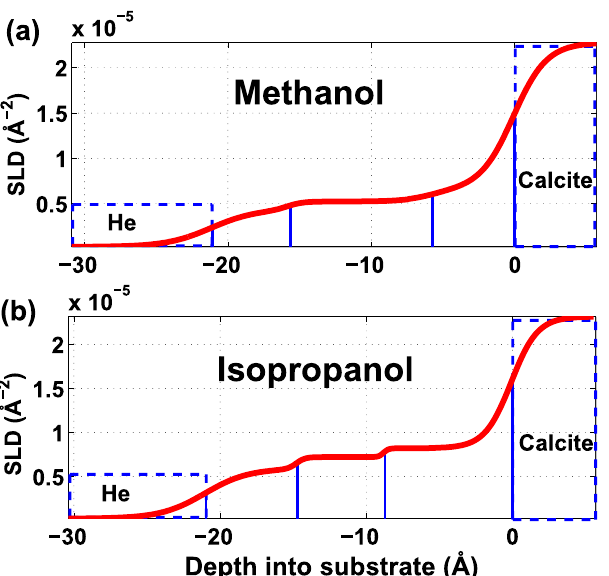
Figure 2. Scattering length density (SLD) based on the fitted model. Calculated SLD for ( a ) methanol, with total thickness of 21 Å and ( b ) isopropanol, with a total thickness of 20.1